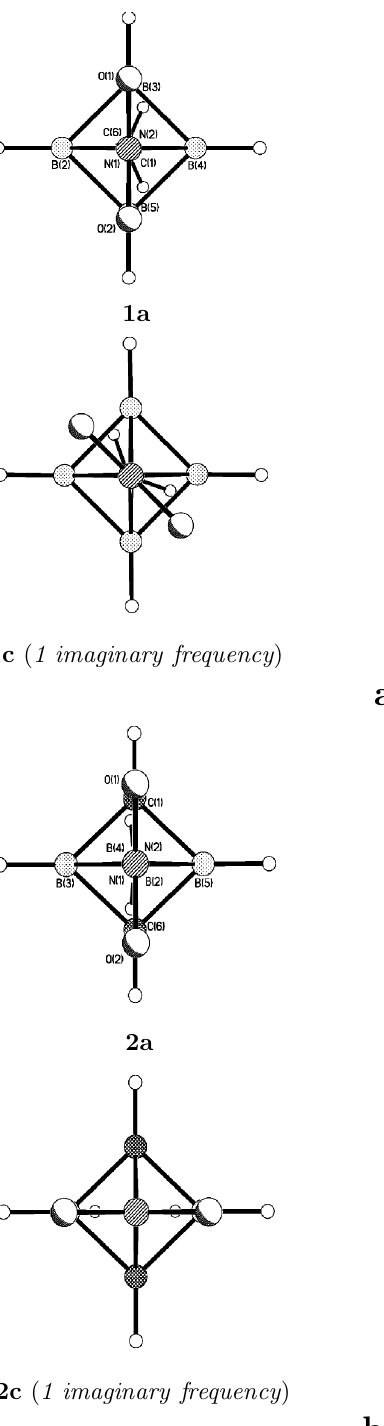
Fig. 1 Structures of calculated conformers of CCCARB (a) and BBCARB (b) molecules. Pro- jections on B(2)-B(3)-B(4)-B(5) plane (a) and on B(3)-C(1)-B(5)-C(6) plane (b) is shown. The presence of imaginary frequences is